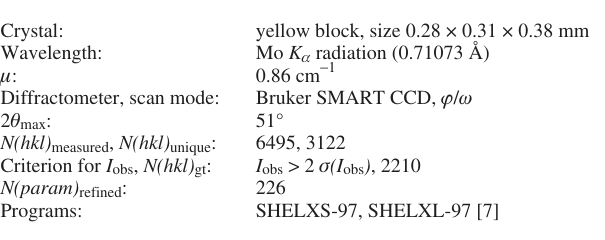
Table 1. Data collection and handling.